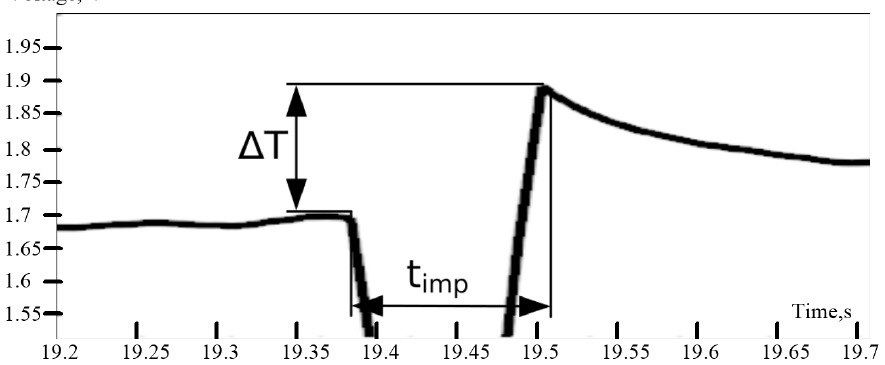
Figure 7. Calibration impulse of the recorder. ∆T—sensor temperature change recorded from output amplification stage (in Volts), t imp —duration of the impulse.